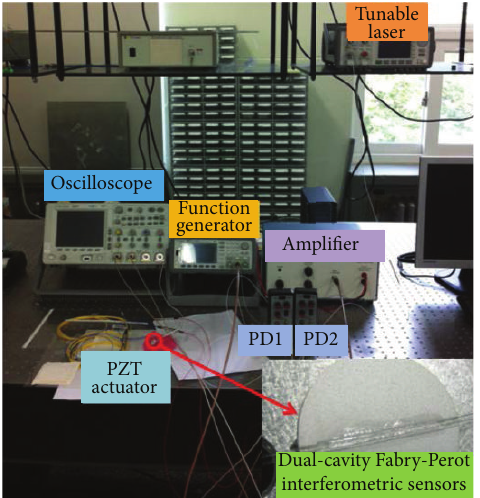
Figure 3: Experimental setup for measuring microvibration by using a dual-cavity fiber Fabry-Perot interferometer.